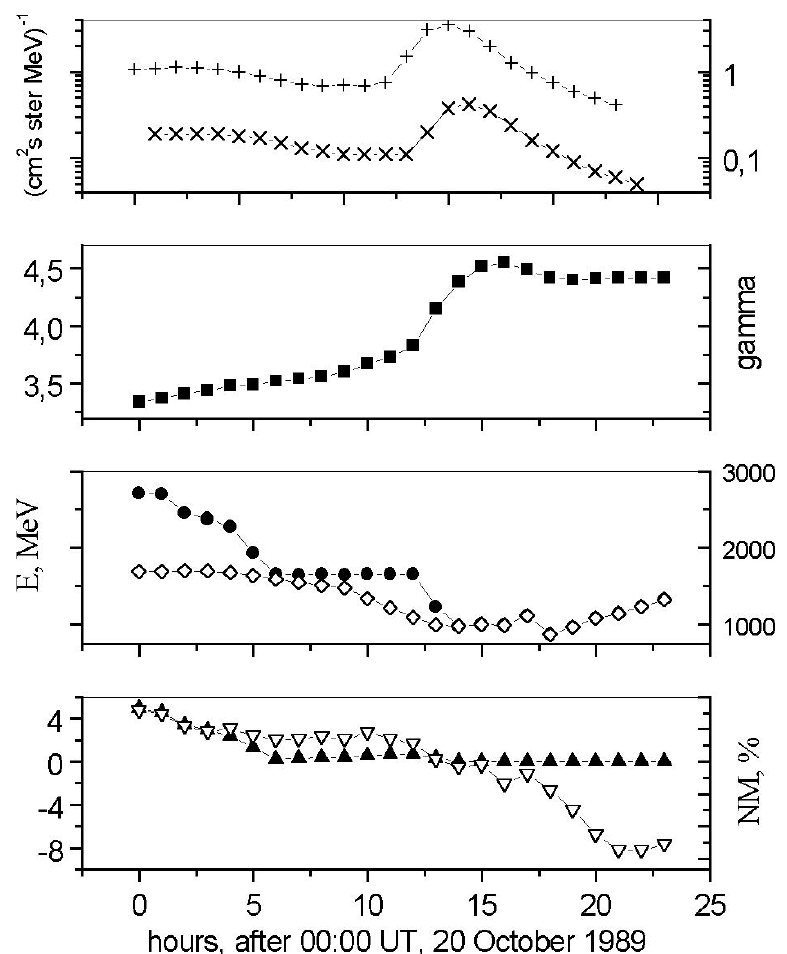
Fig. 1. Proton flux within 84–200 and 110–500MeV energy bands measured by the GOES-7 detector; a power law index of the proton differential energy spectrum deduced from the above data; estimated values of the maximum en- ergy of solar protons and the effective cutoff energy in Moscow; registered to- tal (open down triangles) and estimated solar (black up triangles) CR variations for the Moscow